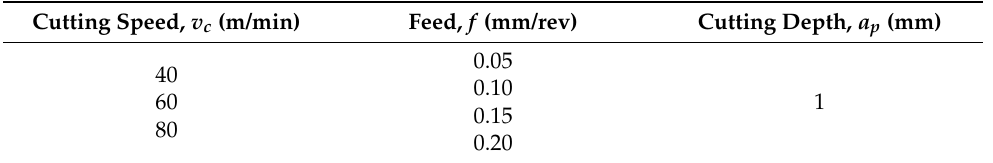
Table 2. Cutting parameters used in the tests.